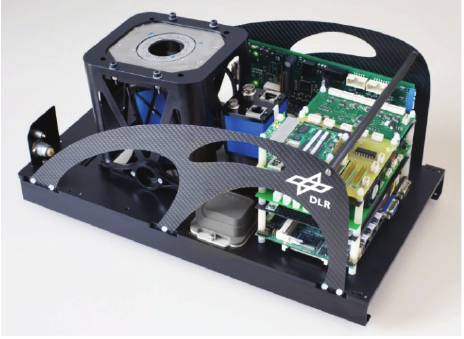
Figure 11. MACS-TumbleCam